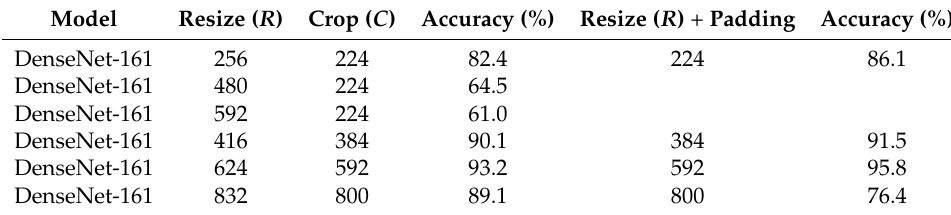
Table 4. Result table for cropping and padding.